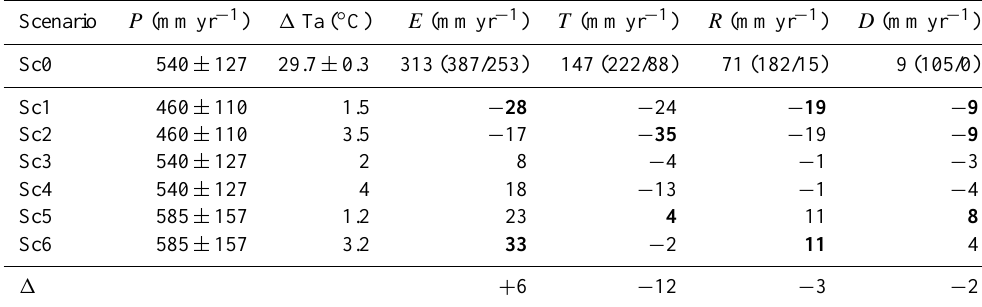
Table 2. Mean annual values for the main components of the water cycle, namely evaporation ( E ), transpiration ( T ), runoff ( R ) and deep drainage ( D ), for the seven scenarios Sc0 to Sc6. Absolute values as well as maximum and minimum values (in brackets) are provided for Sc0. For all other scenarios, values are given as differences in means compared to Sc0. Extreme variations are shown in bold. The last line shows the mean difference ( (cid:49) ) between the scenarios Sc1-Sc6 compared to